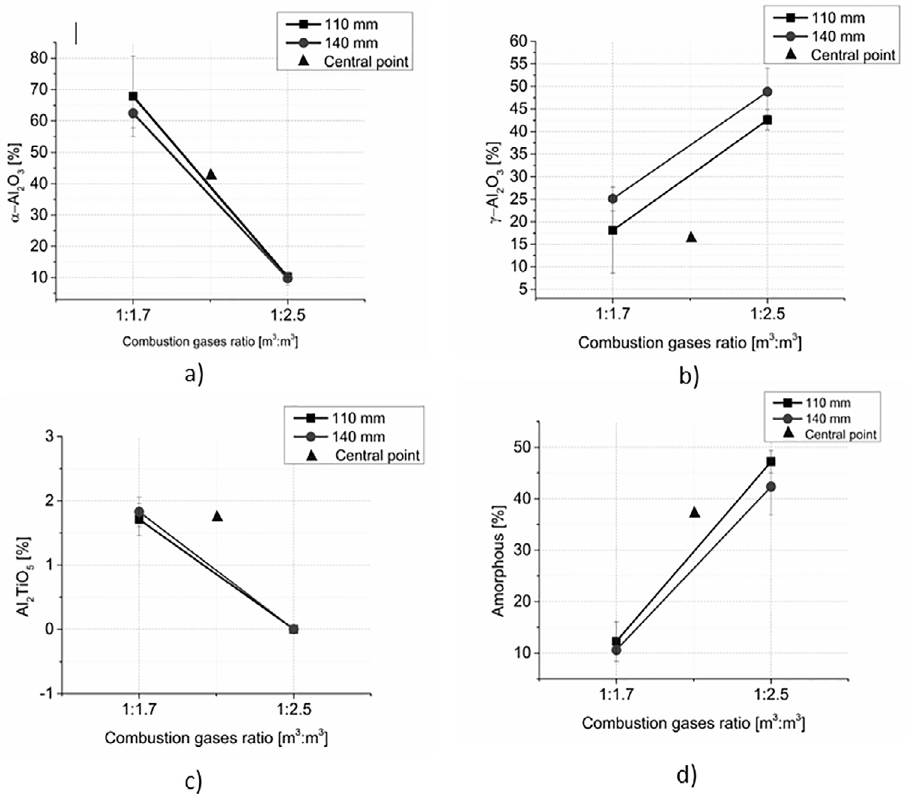
O , b) γ-Al O , c) 2 3 2 3